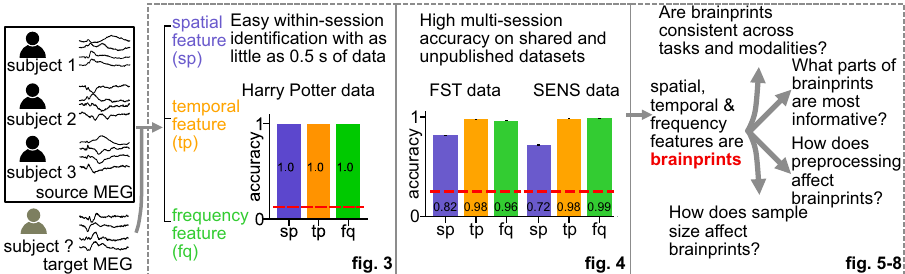
Fig. 2 Graphical abstract. Identifying which subject a segment of MEG data belongs to is strikingly easy when other data from the same session is available for every subject. We propose three types of interpretable features that can also be used to identify individuals across sessions with high accuracy. Identi fi ability of individuals is in fl uenced by factors such as resting state vs. task state, components of each feature, the sample size and the level of preprocessing. Our results reveal aspects of individual variability in MEG signals and highlight privacy risks associated with MEG